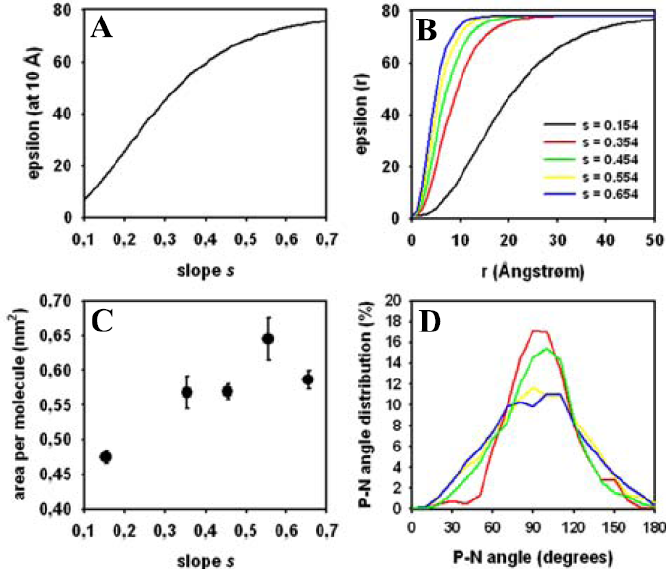
Figure 8. Impact of electrostatic interactions on membrane structure. ( A ) the distance-dependent dielectric constant is plotted as function of the slope, s , as defined in Equation (7) for a fixed distance from a charged group of 10 Å; ( B ) the distance-dependent dielectric constant is plotted as function of the distance from a charged group for various slope values of s = 0.154 (black line), s = 0.354 (red line), s = 0.454 (green line), s = 0.554 (yellow line), and s = 0.654 (blue line), respectively; ( C ) the area per lipid was calculated from the least 40,000 steps of separate MC runs performed with differing slope values of the dielectric constant. The mean ± SD is plotted as function of slope, s ; ( D ) the head group orientation was inferred from the angle between the P–N vector and the bilayer normal and plotted for the separate MC runs. Increasing the slope, s , of the dielectric constant resulted in a broadening of the angle distribution (color coding is as for panel B). See text for more